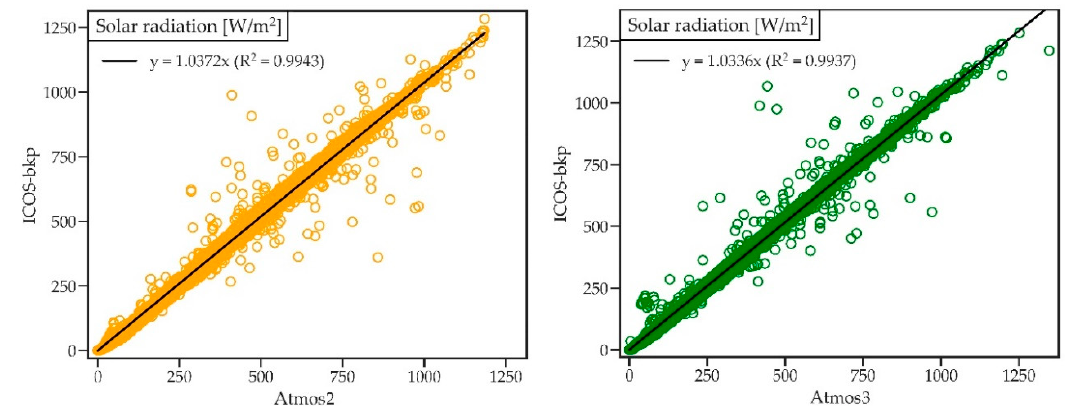
Figure A2. Linear regression for solar radiation for Atmos2 and Atmos3 vs. ICOS-bkp station.